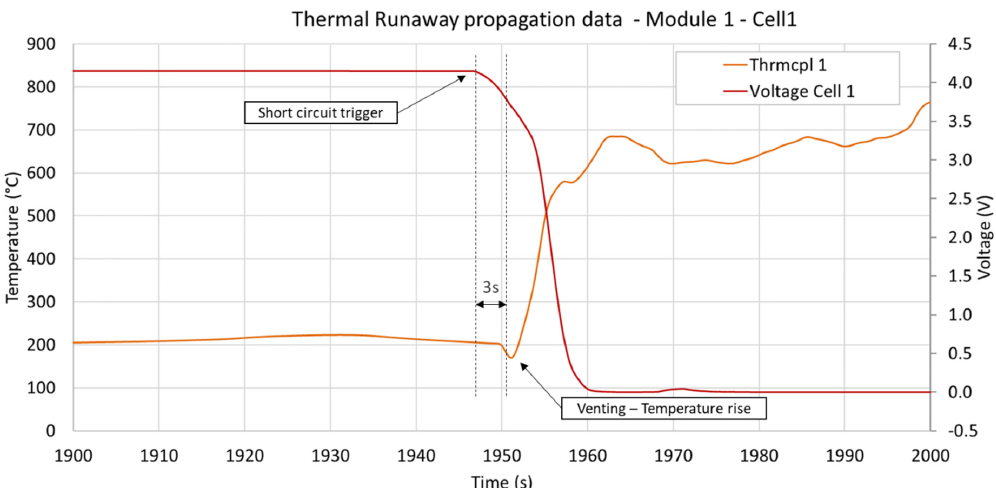
Figure 8. Comparison of temperature and voltage for cell 1 triggered to TR condition. Time between short circuit and temperature rise is approximately 3 s.